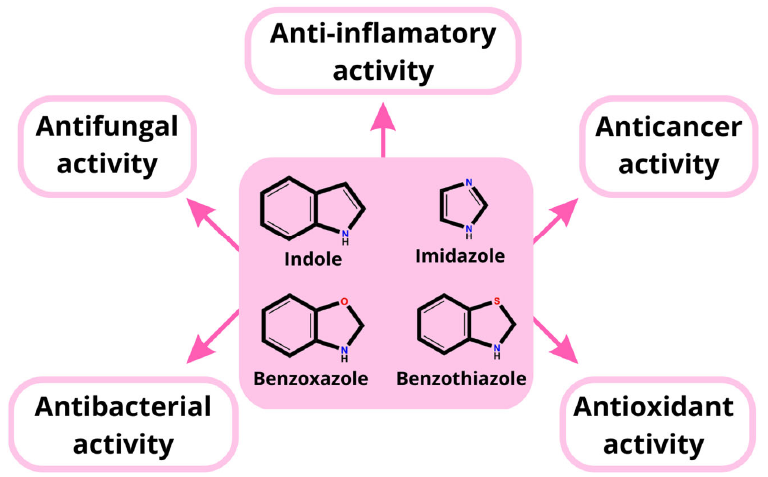
Figure 1. Organic chemistry scaffolds.